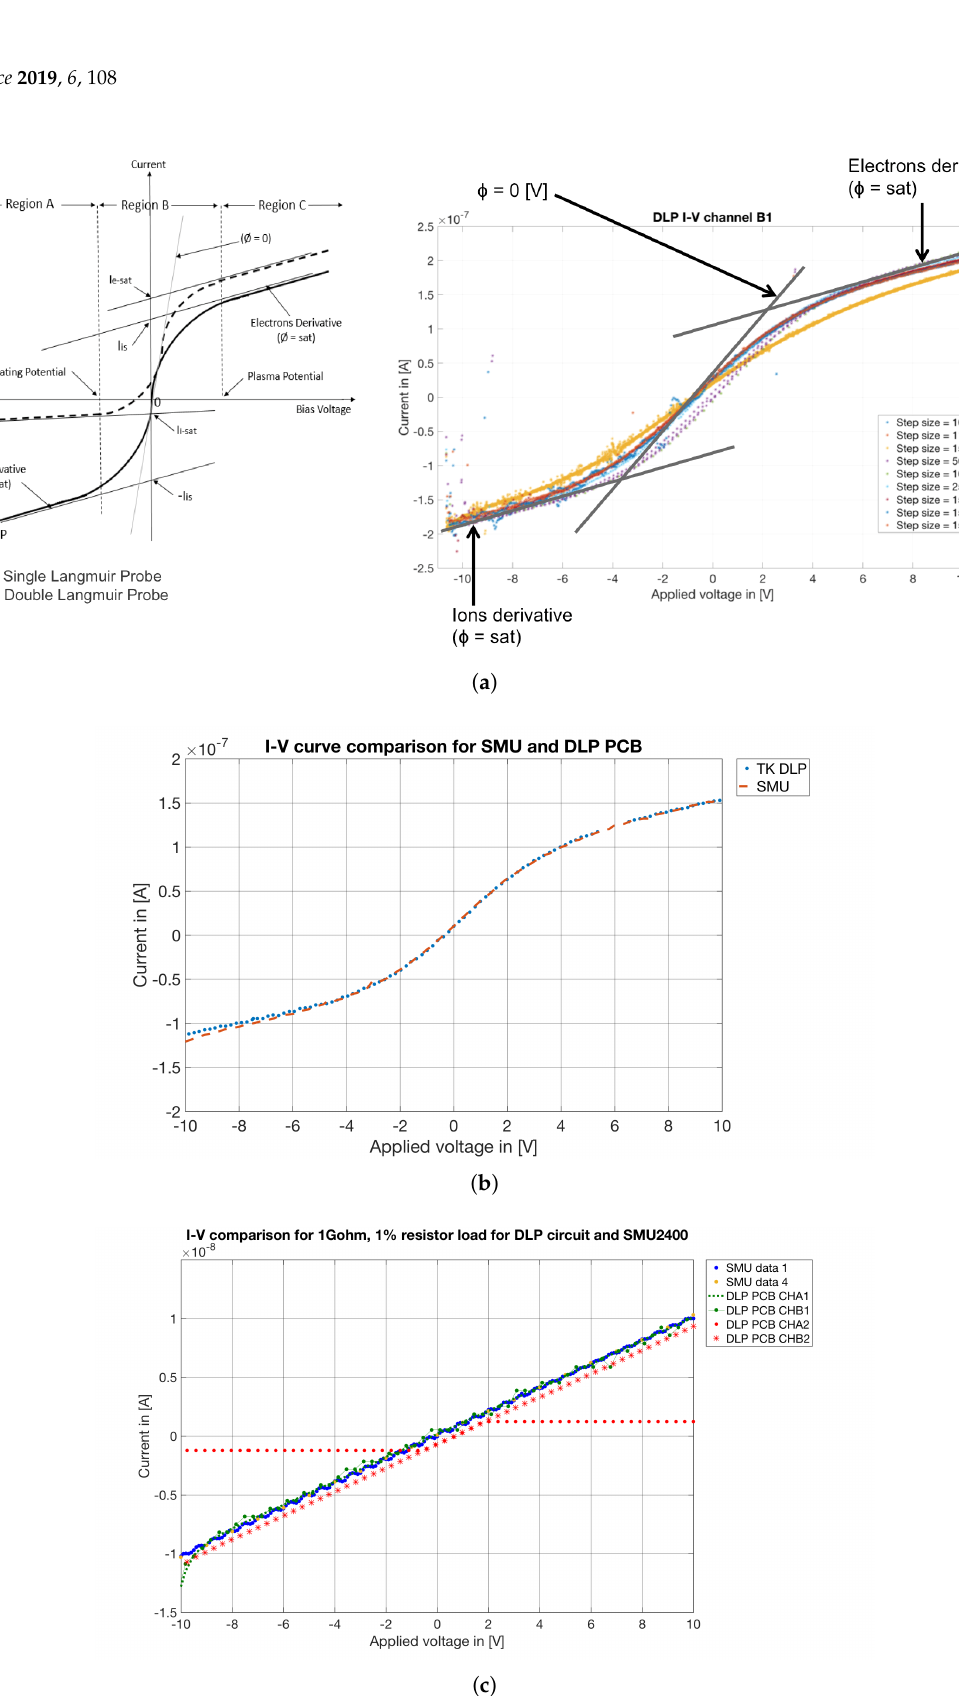
Figure 10. Ground tests results for: ( a ) DLP I–V curve results for different number of samples (DAC step size) and the results comparison to an ideal DLP I–V curve on the left; ( b ) DLP measuring circuit comparison with the SMU for the same plasma conditions inside the LEO plasma chamber; and ( c ) DLP sensitivity and linearity relative calibration by using a 1 G Ω resistor and the SMU2400 instrument. The DLP system has a linear response as expected inside its operating range. The current saturation in channel CHA2 is due to its higher gain compared with the other